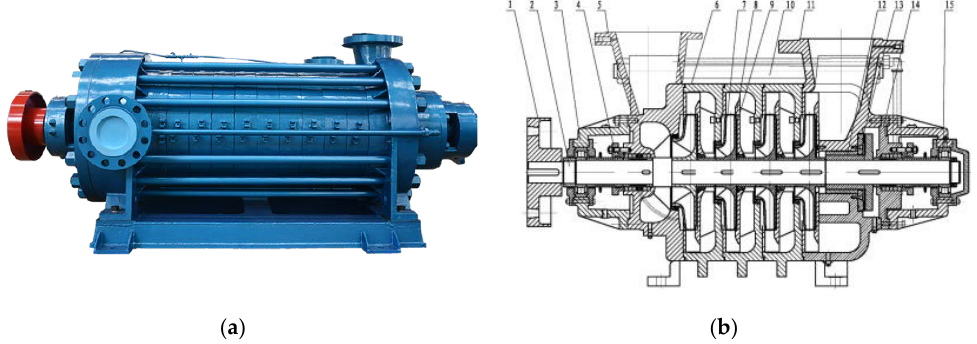
Figure 9. MD500-90 × 7 self-balancing multistage pump. ( a ) Drawing of the MD500-90 × 7 self- balancing multistage pump. ( b ) Design of the MD500-90 × 7 self-balancing multistage